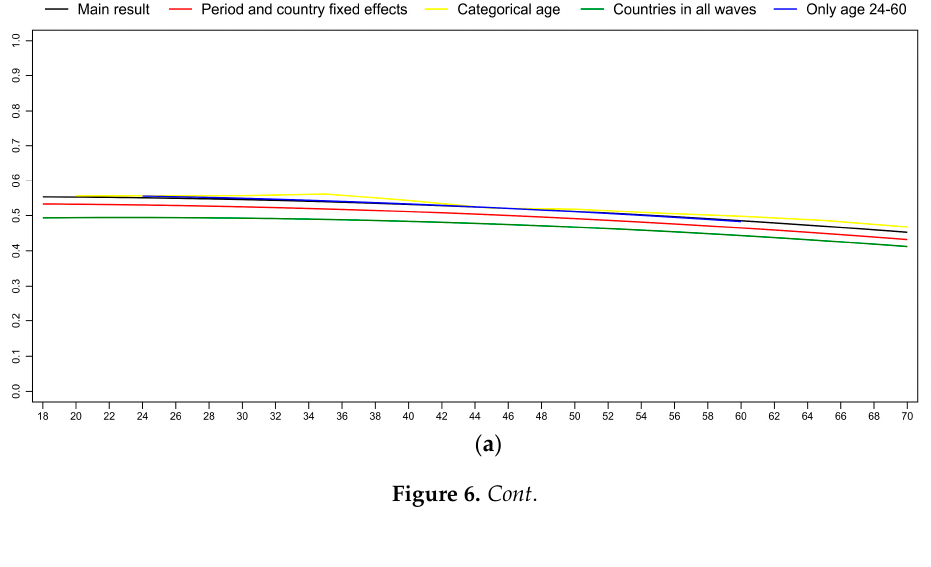
Figure 5. ( a ) Age, ( b ) period, and ( c ) birth-cohort effects on relative importance of work values (hierarchical age-period-cohort regression model). The y -axis shows the predicted value of the dependent variable (for an average respondent).